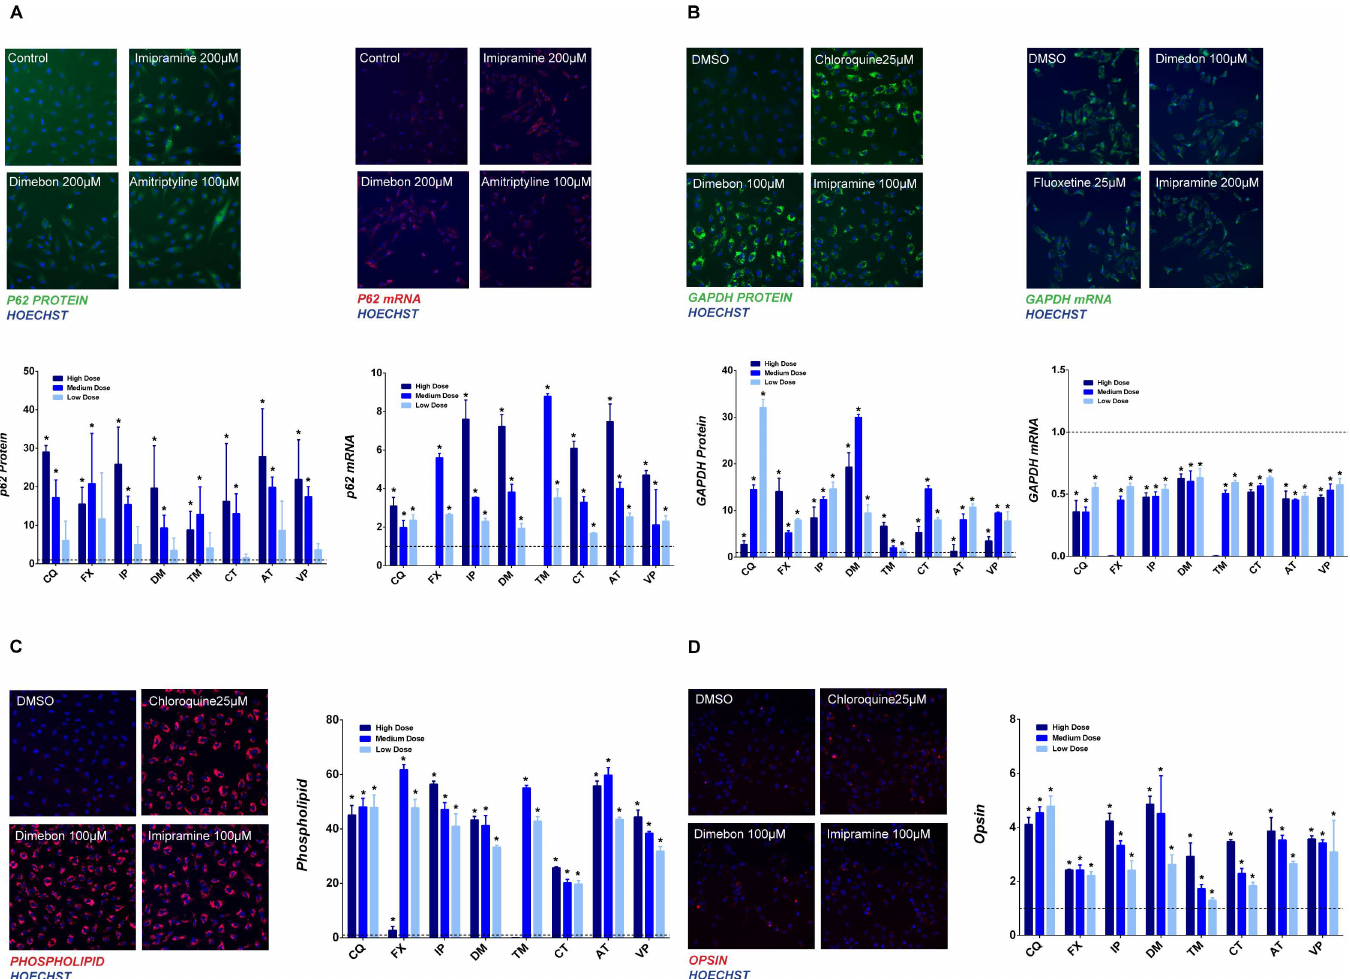
Fig 7. Decreasedlysosomal function. Effect of drug treatment on the abundance of p62 protein and mRNA (A); GAPDH protein and mRNA (B); phospholipid (C); and opsin (D). Quantificationdata in each panel is presented as fold changeof total signalintensity comparedto control (mean ± SD), * p (cid:20) 0.05. Tested drugs includechloroquine (CQ), fluoxetine(FX), imipramine(IP), dimebon(DM), tamoxifen (TM), chloropromazine (CP), amitriptyline(AT), and verapamil (VP).